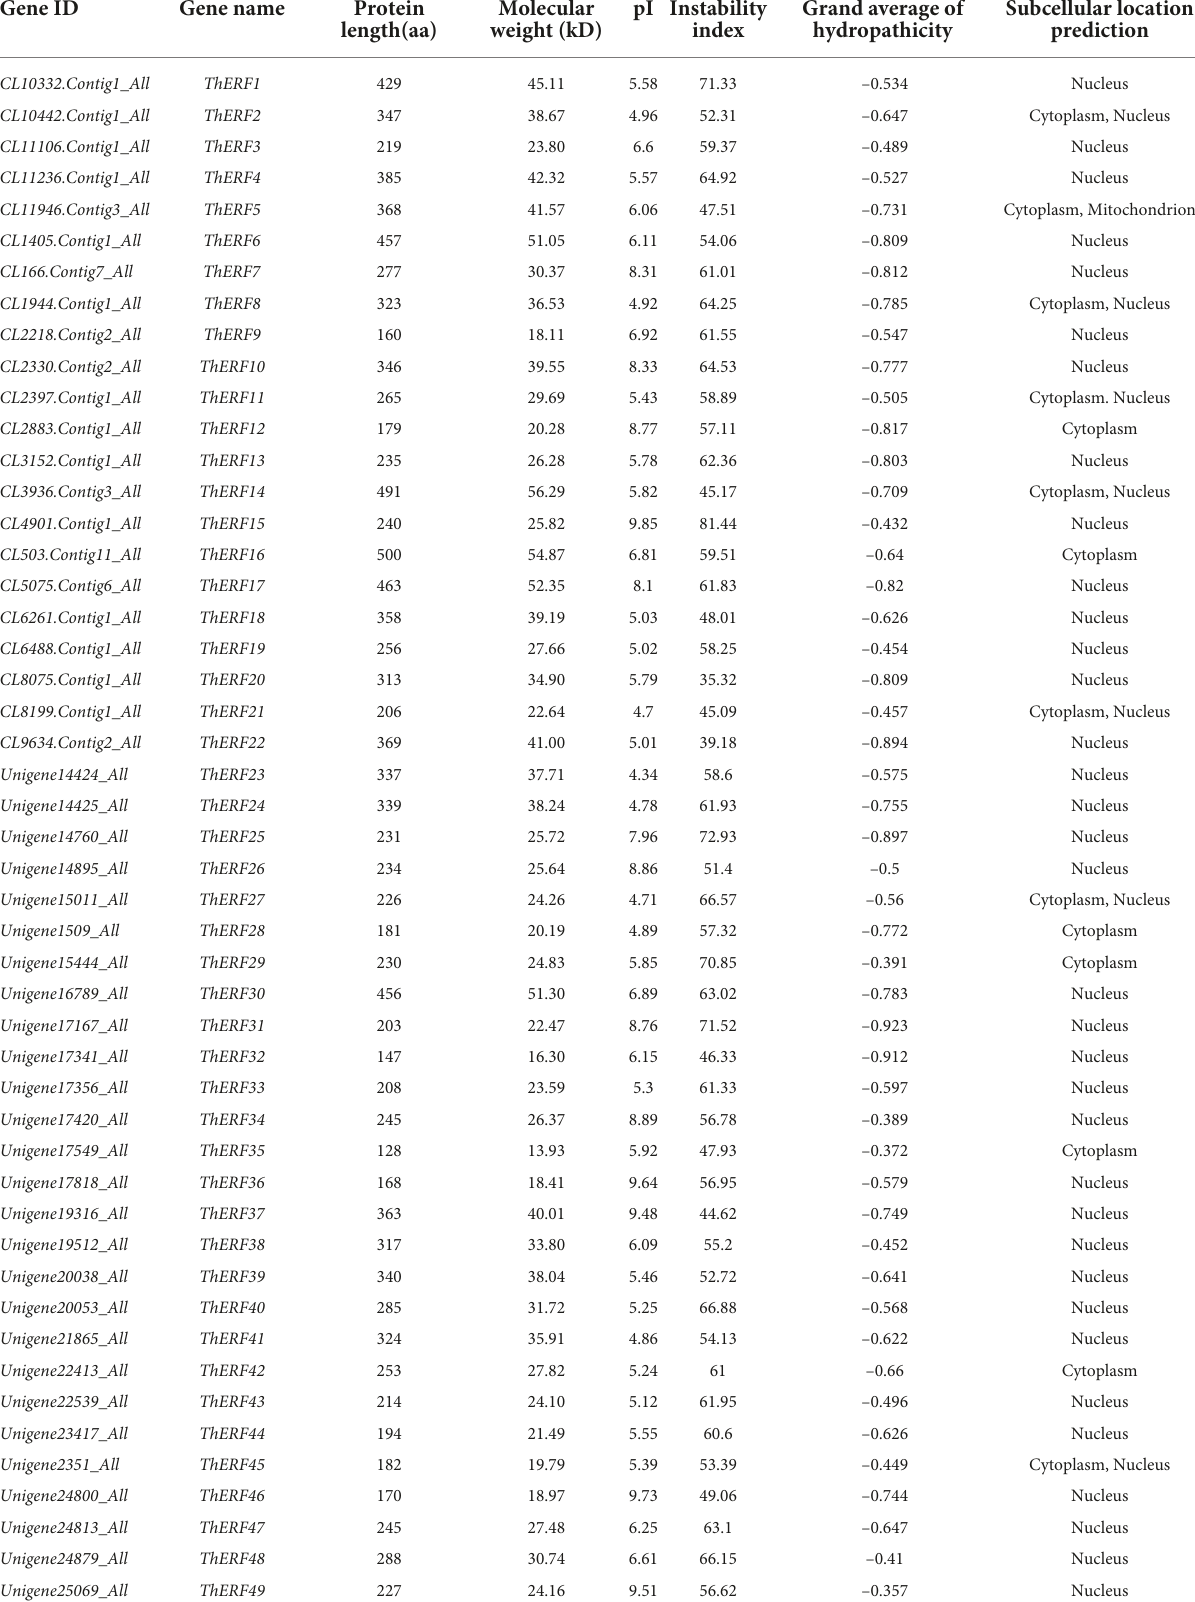
TABLE 1 The AP2/ERF protein information of T. hemsleyanum